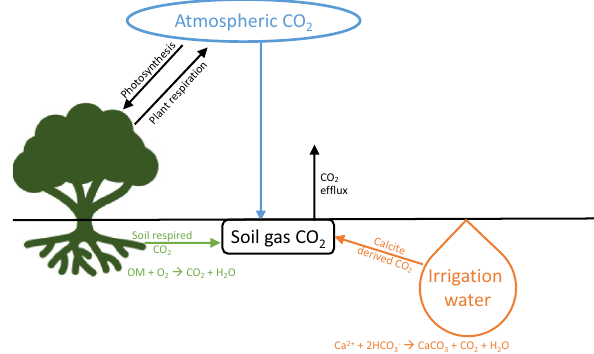
Figure 1. A simplified conceptual model to highlight major CO 2 fluxes and calcite formation pathways in the agricultural fields. Soil CO 2 is contributed by atmospheric, soil respired and calcite derived CO 2